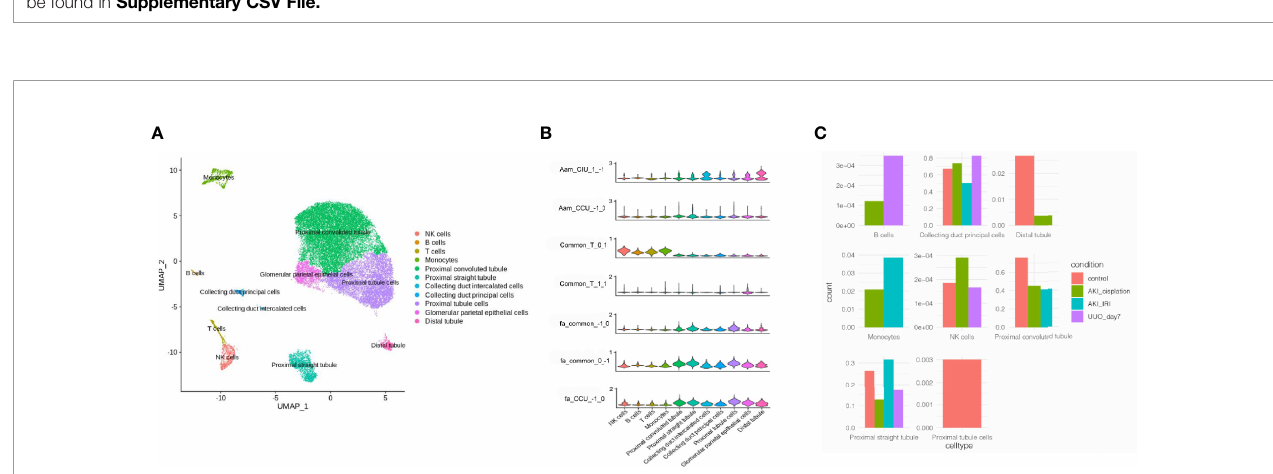
FIGURE 4 | Mapping common and speci fi c genes in single cell data. (A) Cell type distribution of human kidney single-cell RNA-sequencing data. (B) Enrichment of different pathways in each cell type. Aam, arachidonic acid metabolism; Fa, fatty acid metabolic process; T, T cell activation. CIU (from healthy to IRI-induced AKI to fi brosis) or CCU (from healthy to cisplatin-induced AKI to fi brosis), genes in this pathway are speci fi c to CIU or CCU, respectively; Common, genes in this pathway are shared in the same module of CIU/CCU. 1 − 1, − 10, 01, 11, and 1 − 1, refer to the gene module. (C) Cell counts in different patterns.